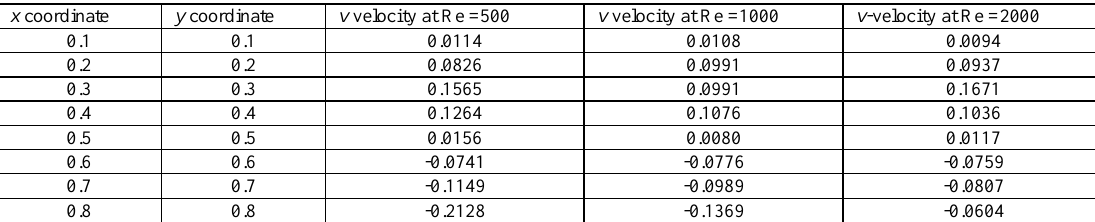
Table 2. v -velocity at different nodes and different values of Re at t =15